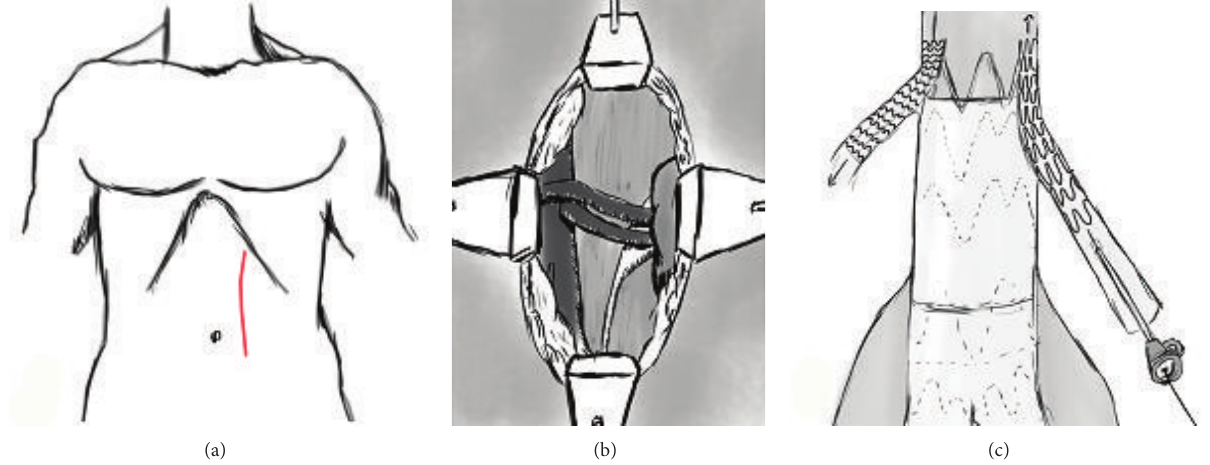
Figure 4: Left retroperitoneal approach: abdominal incision for left retroperitoneal approach to the renal artery (a). Surgical exposure of the main trunk of the left renal artery (b). Retrograde insertion of a 5 Fr short sheath and subsequent 6mm × 18mm balloon expandable stent deployment